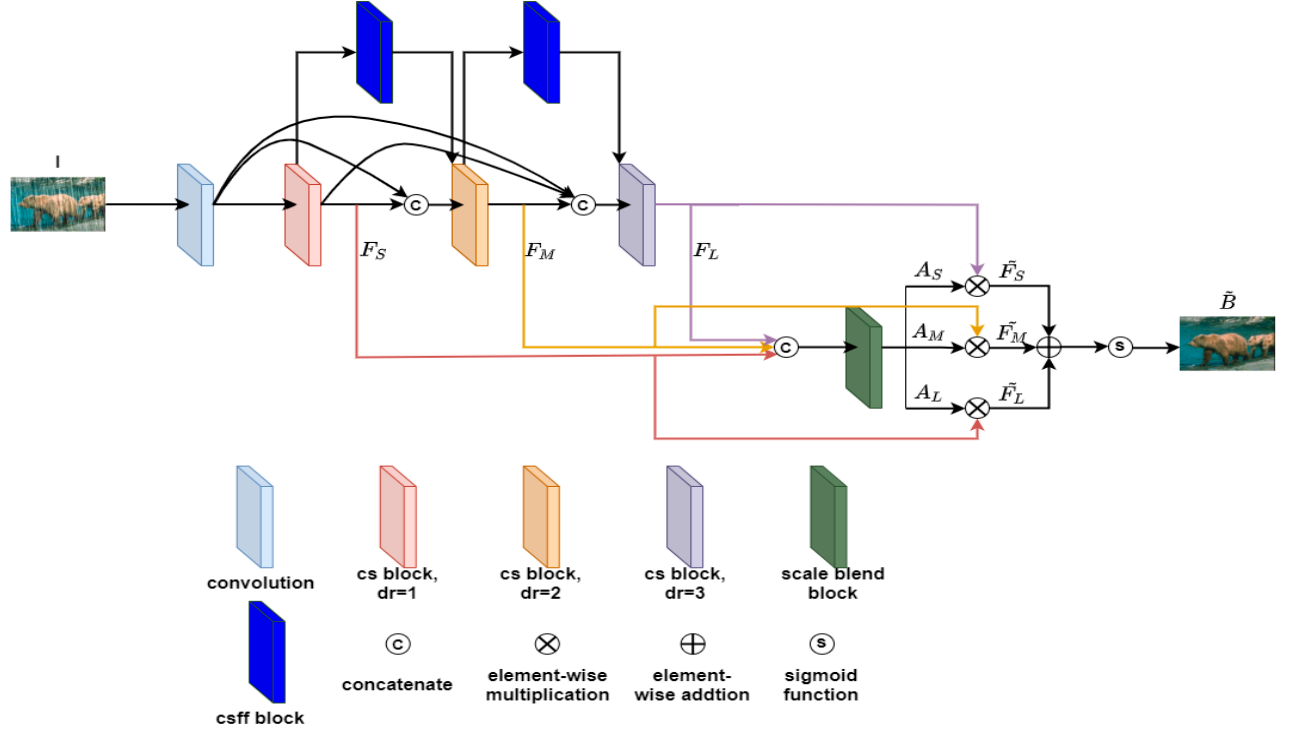
Figure 1. Outline of proposed MARCAFNet.